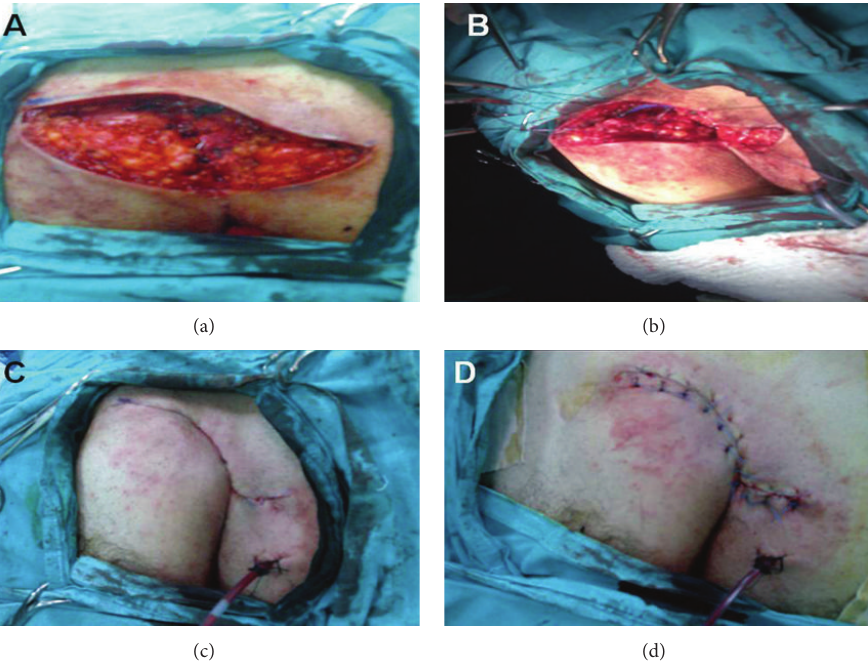
Figure 3: Demonstration of the patient’s operation: (a) resection of the pilonidal cyst and the sinus tracts with the underlying subcutaneous tissue and fat; (b) a relaxation incision was made in the fascial layers of the wound edges, by incising the gluteus muscle fascia vertically on either side, which allowed rotation of the skin and the underlying tissue for tension-free primary closure; (c) both wound edges were approximated subcutaneously with deep interrupted sutures using 0 polyglactin; (d) a closed suction drain was inserted in the cavity.